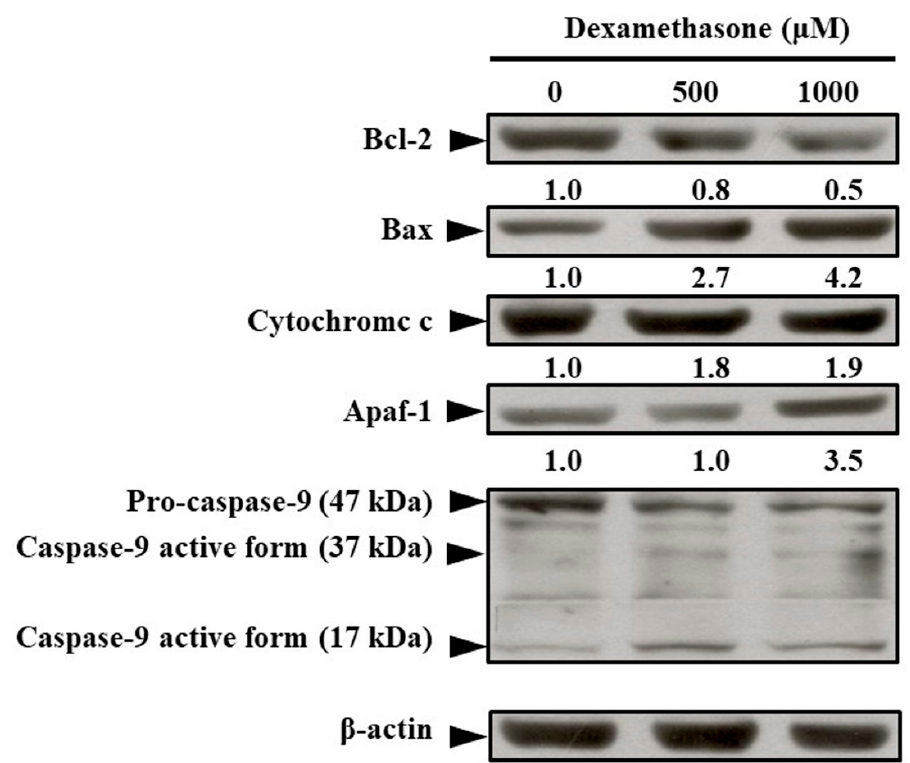
Figure 4. E ff ect of dexamethasone on apoptotic signaling of C2C12 myotube cells. The cells were treated with or without 500 and 1000 µ M dexamethasone for 24 h. Thereafter, cell lysates were collected and blotted using specific antibodies, including Bcl-2, Bax, cytochrome c, Apaf-1, pro-caspase-9, and caspase-9, and then subjected to Western blot analysis as described in the Materials and Methods section. Each lane of protein signaling was normalized to β -actin. Each band was quantified using ImageJ software.